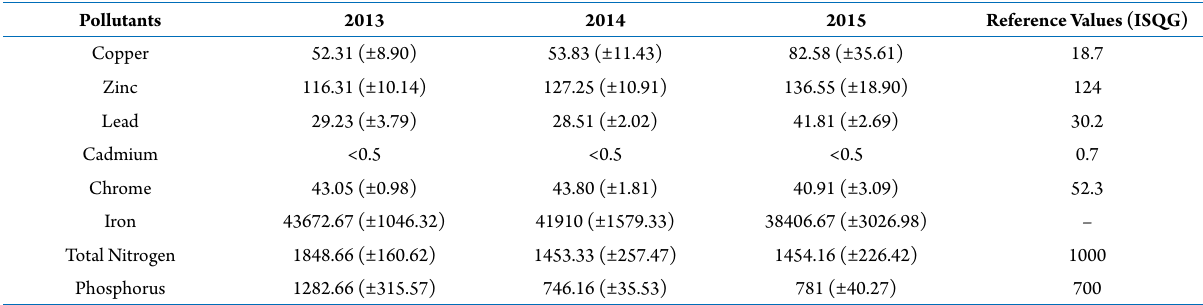
Table 1. Concentrations (mean ± standard error) (mg/kg) of heavy metals, total nitrogen, and phosphorus present in the sediment in Saco da Ribeira. Reference values are in the CETESB Reports. (CETESB 2013, 2014 and 2015). “–” = Absence of reference